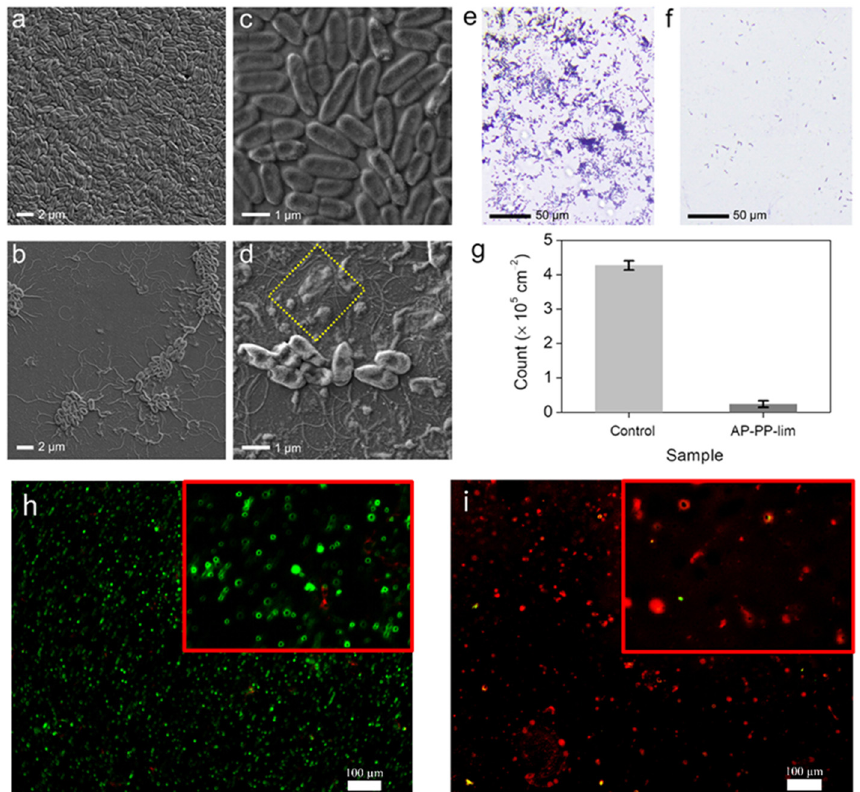
Figure 6. Antimicrobial performance of AP − PP − lim nano-thin films against Gram-negative ( E. coli ) bacteria. FESEM images of treated E. coli on the ( a , c ) control and ( b , d ) AP − PP − lim sample. The yellow square box indicates the rupture of E. coli cells. Fluorescent microscopic imaging of treated crystal violet-stained E. coli on the ( e ) control and ( f ) AP − PP − lim sample. ( g ) Count of treated E. coli per unit area (cm − 2 ) on the control and AP − PP − lim sample. Illustrative fluorescence views in live-dead fluorescence assay of ( h ) E. coli attached on clean glass substrate and ( i ) E. coli attached on AP − PP − lim. Samples were incubated for 24 h. Live bacteria are represented by green, whereas dead bacteria are represented by red.